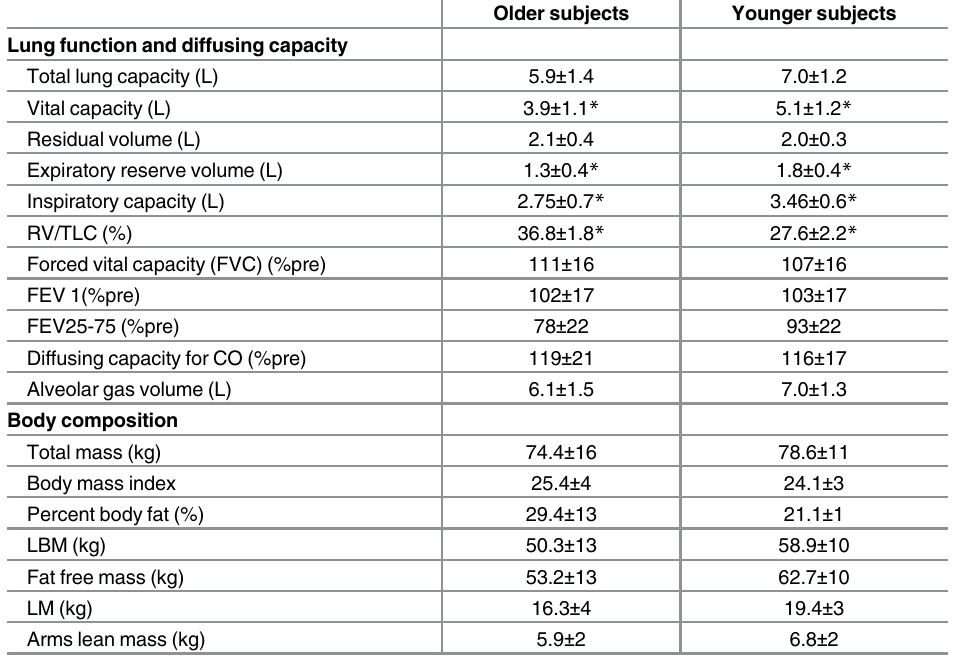
* indicates a signi fi cant difference between older and younger rowers (p < 0.05). Respiratory exchange ratio (no exertion ~ maximal exertion: 6 ~